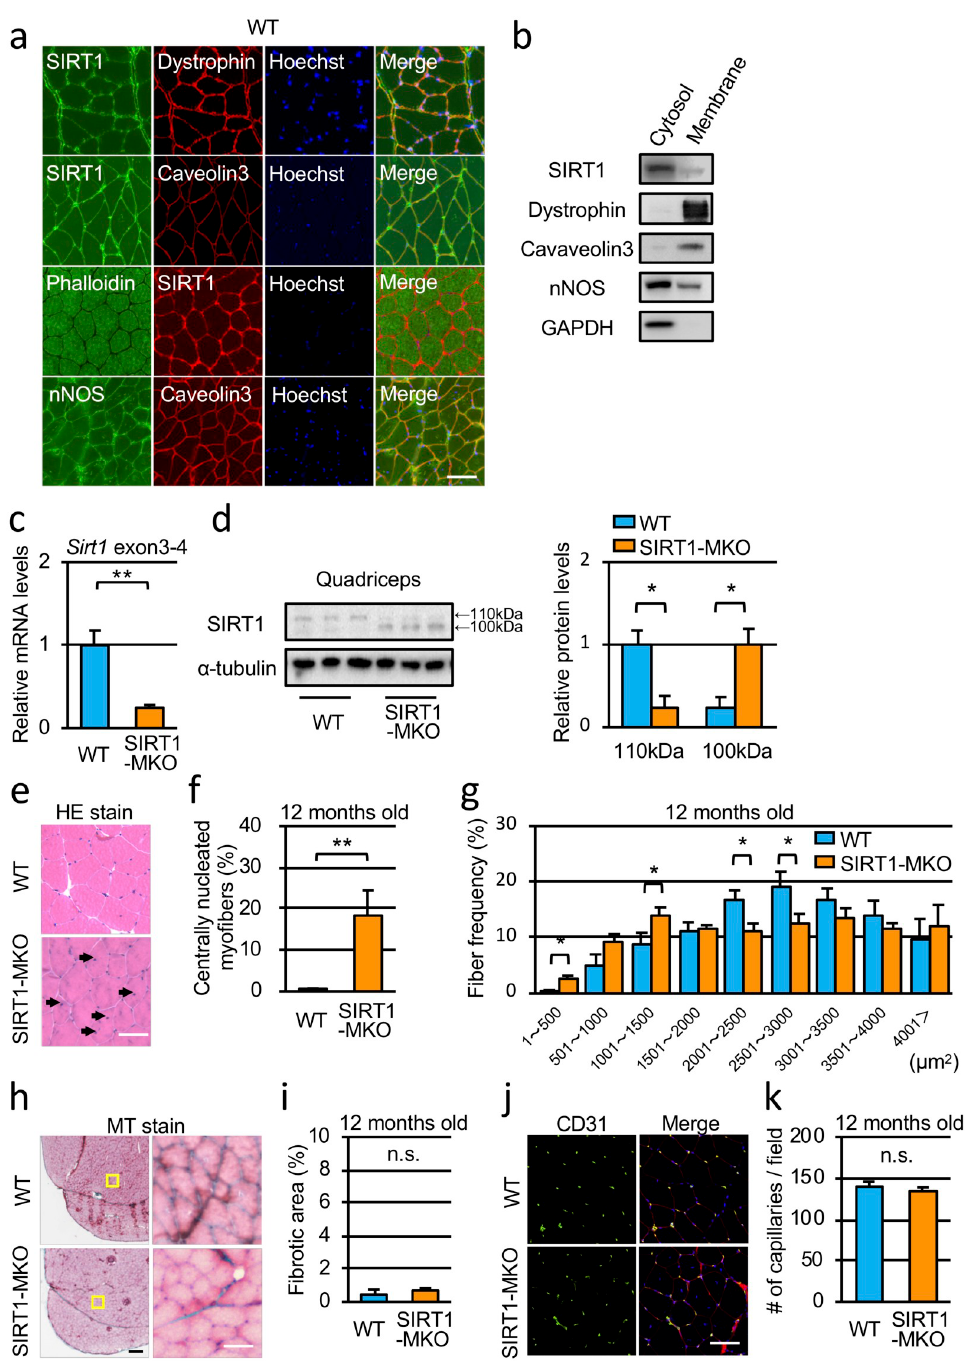
Fig 1. SIRT1-MKO mice have mild dystrophic pathology. (a) Immunofluorescence staining for SIRT1 (ab110304, Abcam), dystrophin, caveolin 3 and nNOS in muscle sections from WT mice at 6 months of age. Cytoplasm of skeletal muscles was stained with phalloidin. (b) Immunoblots of cytoplasmic fraction and membrane fraction of quadricepses from WT mice. (c) Levels of Sirt1 mRNA containing exon 3 and exon 4 in quadriceps of WT and SIRT1-MKO mice at 12 months of age were analyzed by qPCR using primers amplifying the region (n = 3). (d) Immunoblots of quadriceps from WT and SIRT1-MKO. The band of WT SIRT1 is detected around 110 kDa, whereas the band of mutant SIRT1, which defects amino acid sequence derived from Sirt1 gene exon 4, is found at 100 kDa. Immunoblot for α -tubulin was used as a loading control. (e) Hematoxylin and eosin (HE) staining of quadriceps from WT (top) and SIRT1-MKO (bottom) mice at 12 months of age. The arrows indicate centrally nucleated myofibers. (f) Frequency of centrally